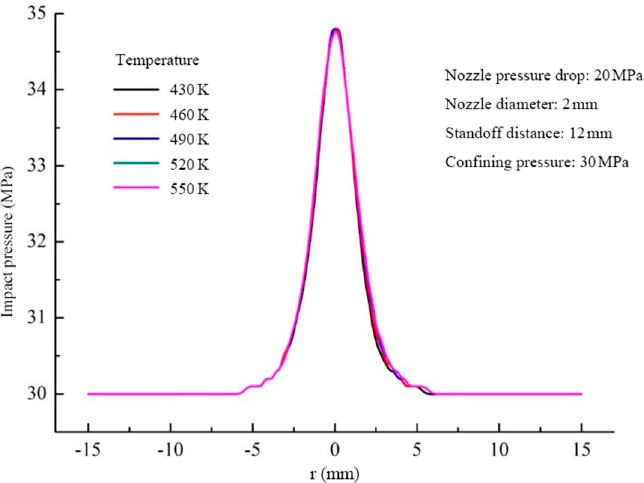
Figure 10. Influence of fluid temperature on impact pressure.